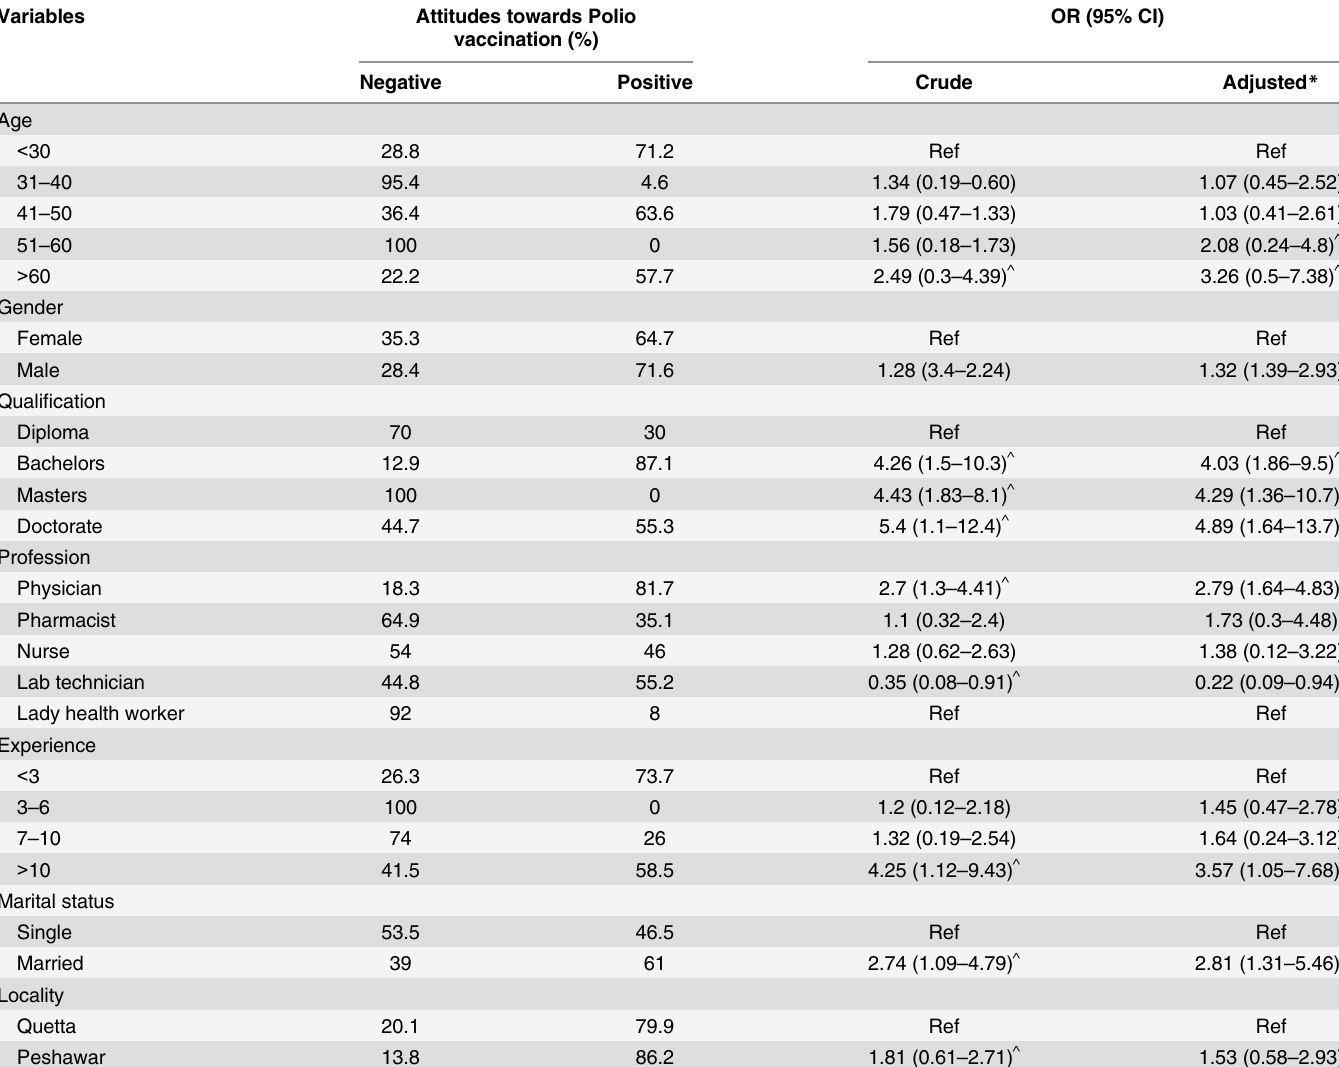
Table 5. Correlates of attitudes towards polio vaccination with demographic variables among healthcare workers Peshawar and